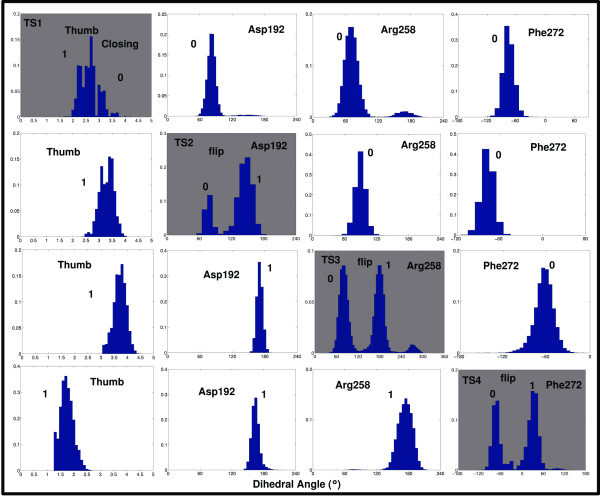
Order parameter distributions in the 8-oxoG:dATP system. Normalized probability distributions of the order parameters of transition states 1 to 4 (TS1 to TS4) in the 8-oxoG:dATP complex. Labels 0 and 1 indicate the open and closed state conformations of the residues and thumb subdomain.